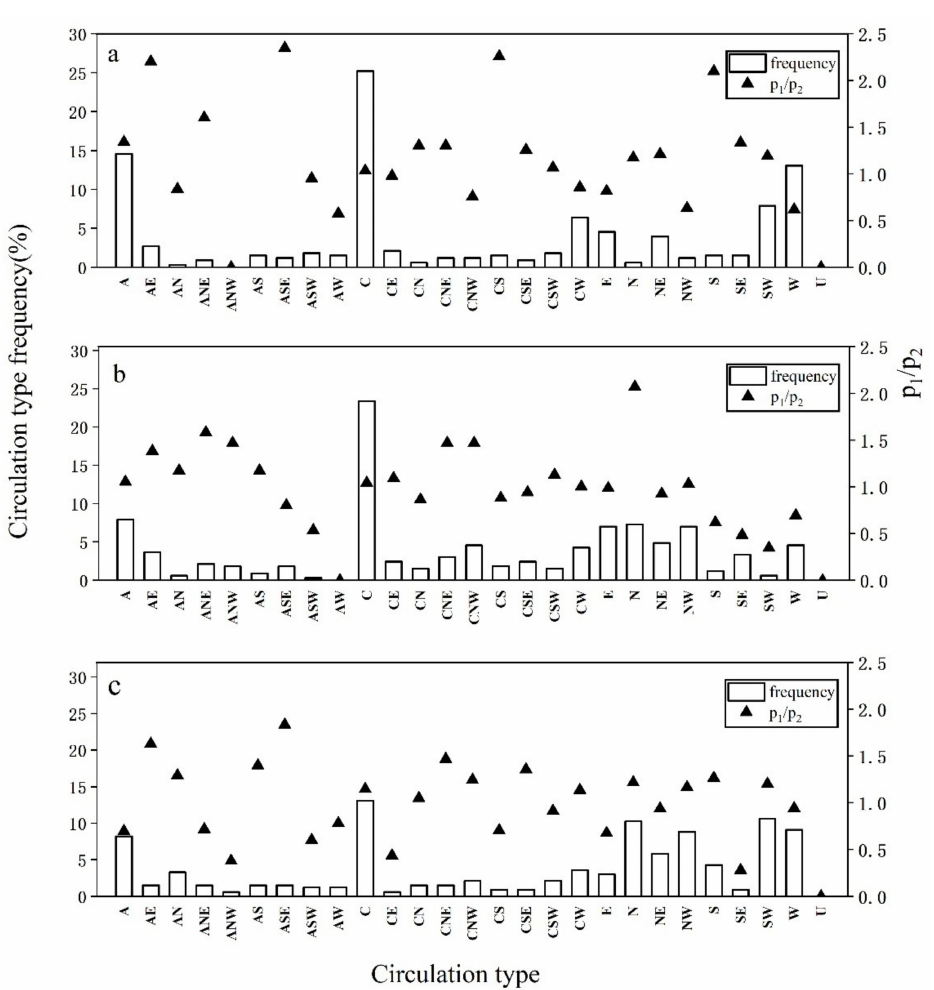
Figure 3. Frequency of each circulation type and its ratio P 1 / P 2 in ( a ) the southern Xinjiang basin, ( b ) western Inner Mongolia and southern Mongolia, and ( c ) the center of Inner Mongolia in spring from 2000 to